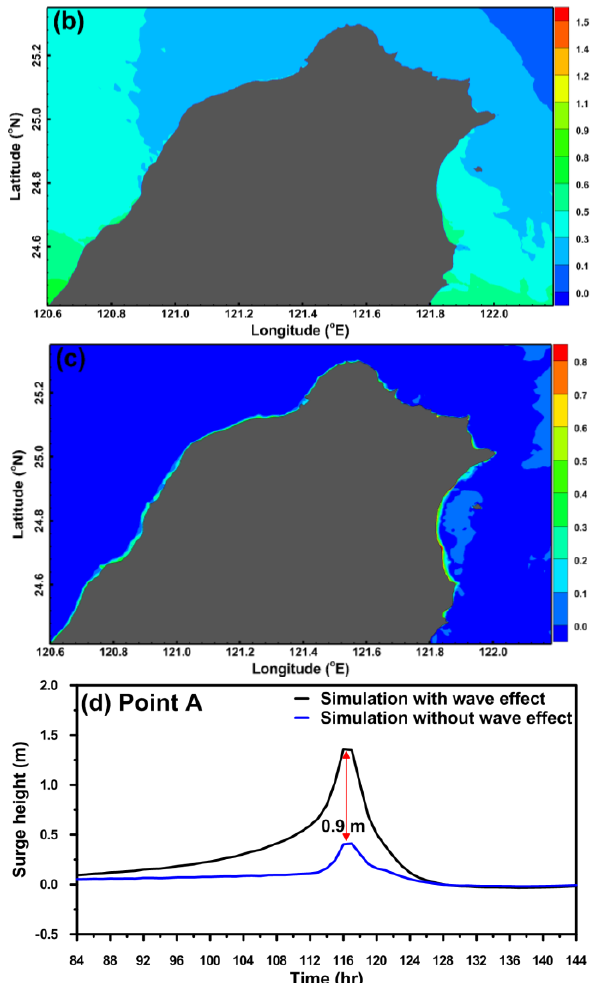
Figure 6. Storm surge and track of Typhoon Dujuan (2015) ( a ) with and ( b ) without a wave effect; ( c ) the wave setup distribution and ( d ) the comparison in the time series of the storm surge with and without a wave e ff ect at point A (as shown in Figure